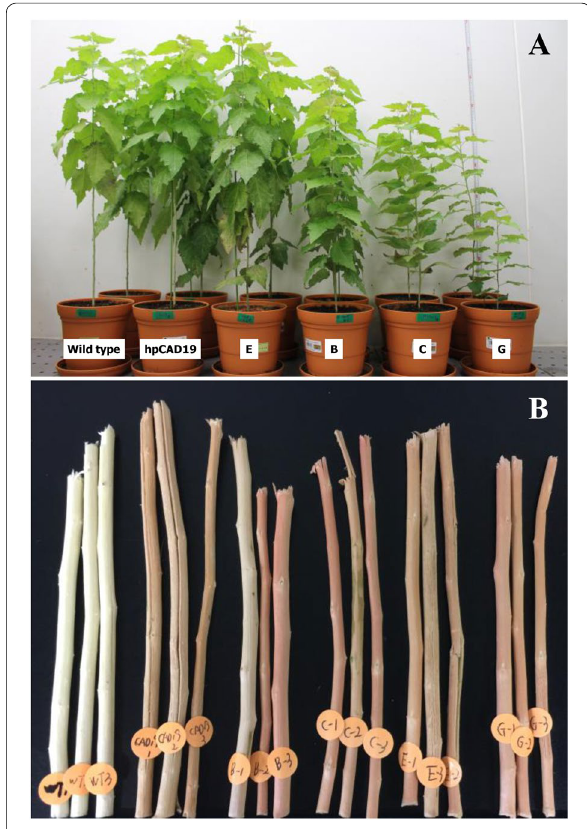
Fig. 1 Phenotype of transgenic lines with an OsSWN1 construct. A Representatives of 4-month-old wild-type and transgenic poplar plants grown under culture room conditions. Two plants each of the same line are placed in tandem. From left to right: Wild-type, hpCAD19, lines #E, #B, #C, and #G plants. At 4 months, the height of plants #C and #G were significantly lower than that of the background line (hpCAD19) ( P < 0.05 and P < 0.01, respectively). A statistical difference was determined by one-way ANOVA followed by Tukey–Kramer multiple comparison tests. B Dried debarked stems prepared from plants of each line. From left to right, wild type,